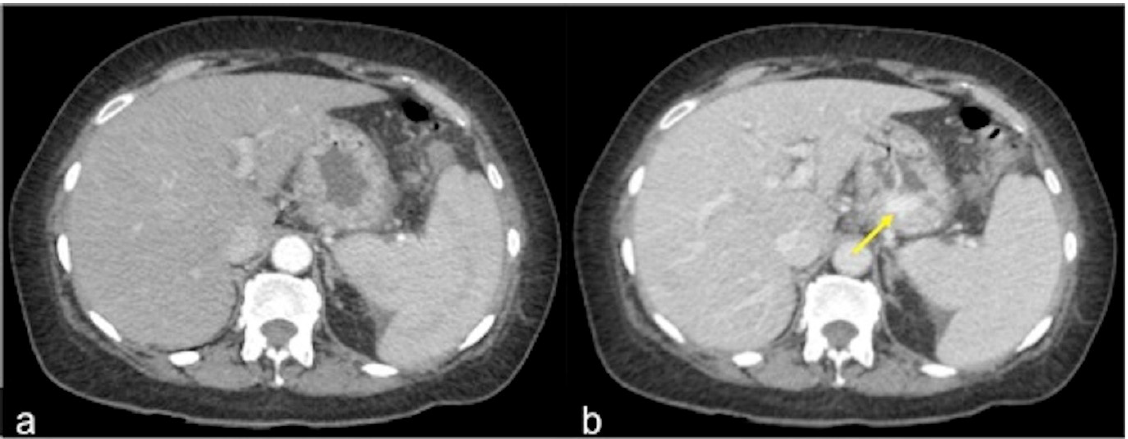
Figure 14. CTA multiphasic study of venous gastric bleeding in arterial ( a ) and venous ( b ) phases. In the venous phase, it is possible to see an amorphous haemorrhagic collection (( b ) arrow), not detectable in the arterial phase.